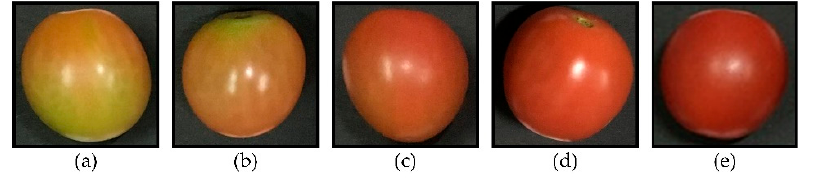
Figure 2. Tomato samples at five maturity stages. ( a ) Breaker stage; ( b ) Turning stage; ( c ) Pink stage; ( d ) Light red stage; ( e ) Red stage.